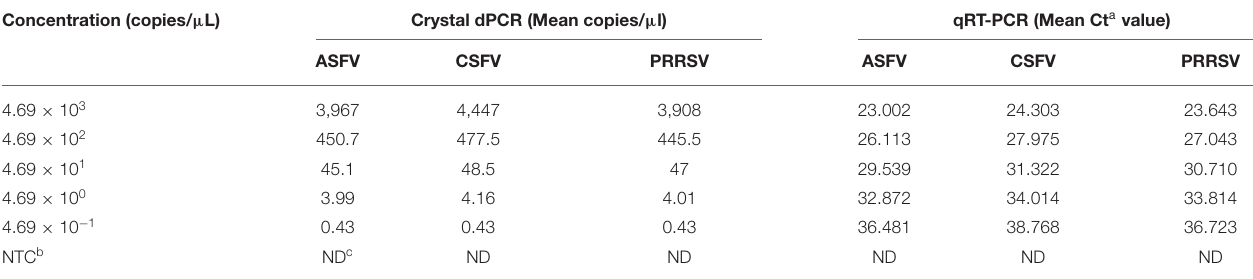
TABLE 4 | Sensitivity comparison of the multiplex crystal dPCR and the multiplex qRT-PCR. Concentration (copies/ µ